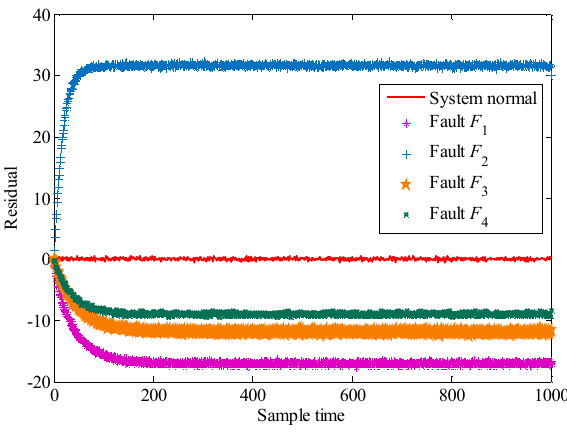
Figure 6. Residual curve under measurement errors.